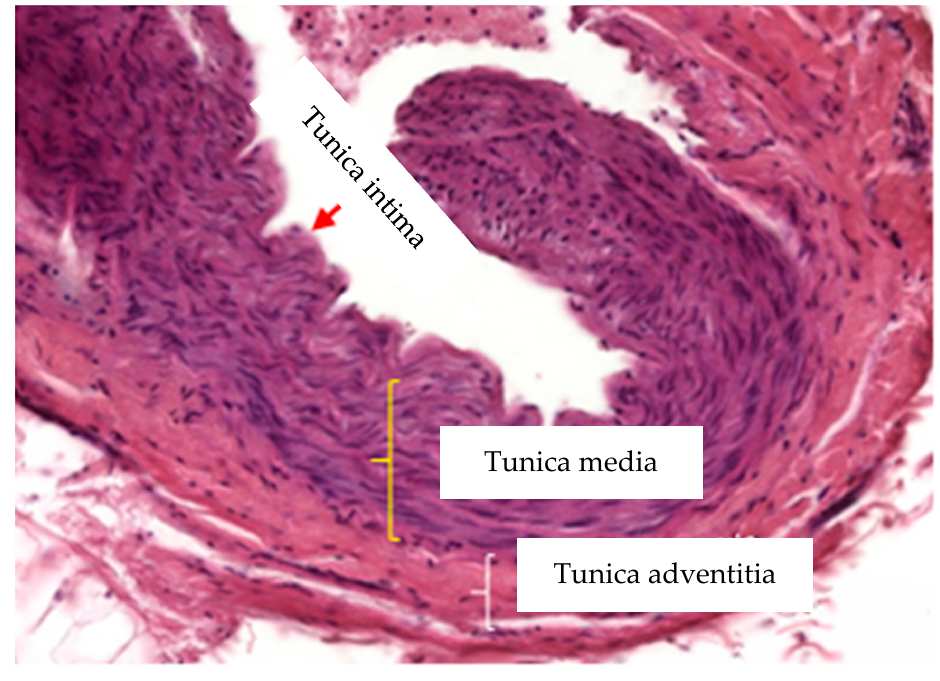
Figure 2. Tunics in wall of elastic artery .